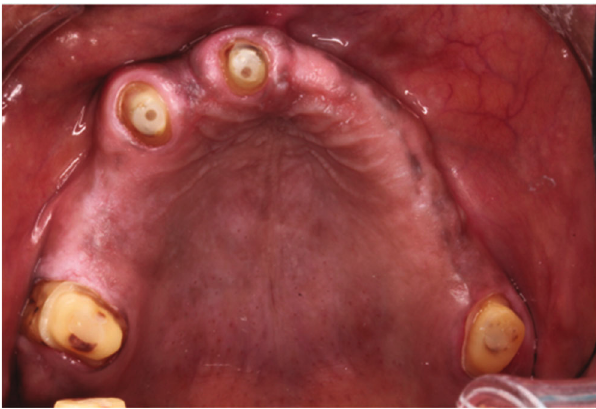
Figure 7: Crown preparation on (FDI 16, 13, 11, and 26). Figure 8: Try-in metal copings in patient mouth (FDI 16, 13, 11, and 26).